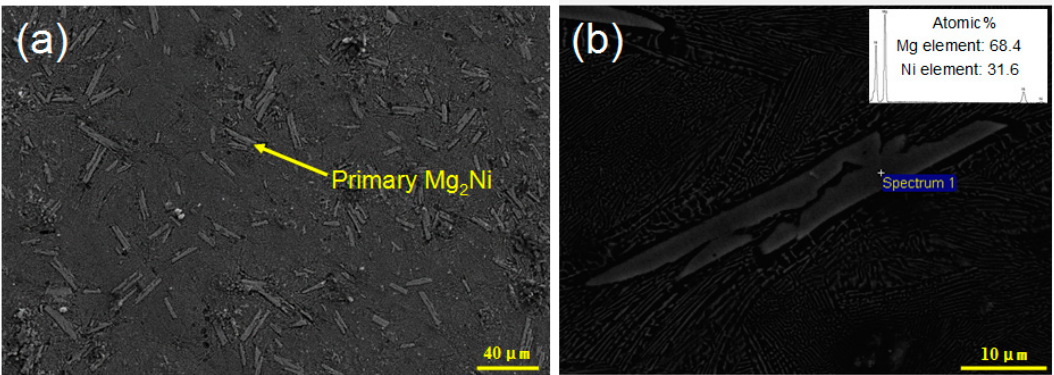
Figure 3. ( a ) Microstructure of Mg–25.6Ni alloy (designated as alloy C), and ( b ) the morphology and energy-dispersive X-ray spectroscopy result of the primary Mg 2 Ni.